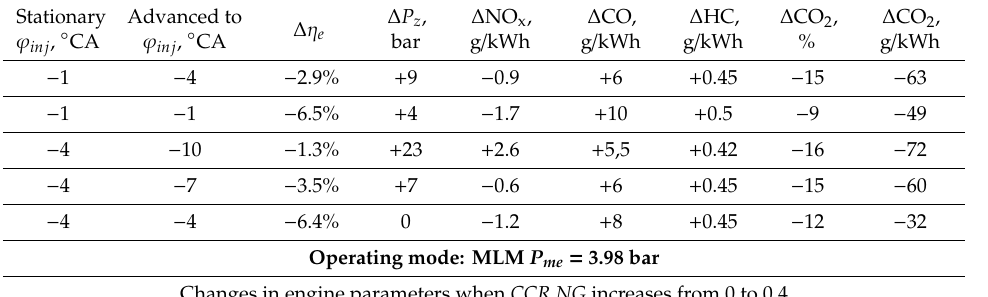
Table 8. Influence of investigated engine (79.5/95.5) conversion to operation with NG fuel feed on energy efficiency and emission parameters.